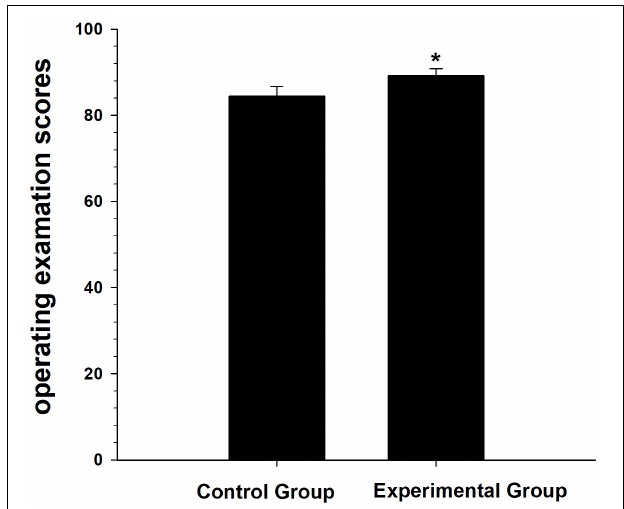
FIGURE 1 | Comparison of the experimentation operating examination results for the two groups of students. The average result for the teaching reform group was significantly higher. * P < 0.05 vs.